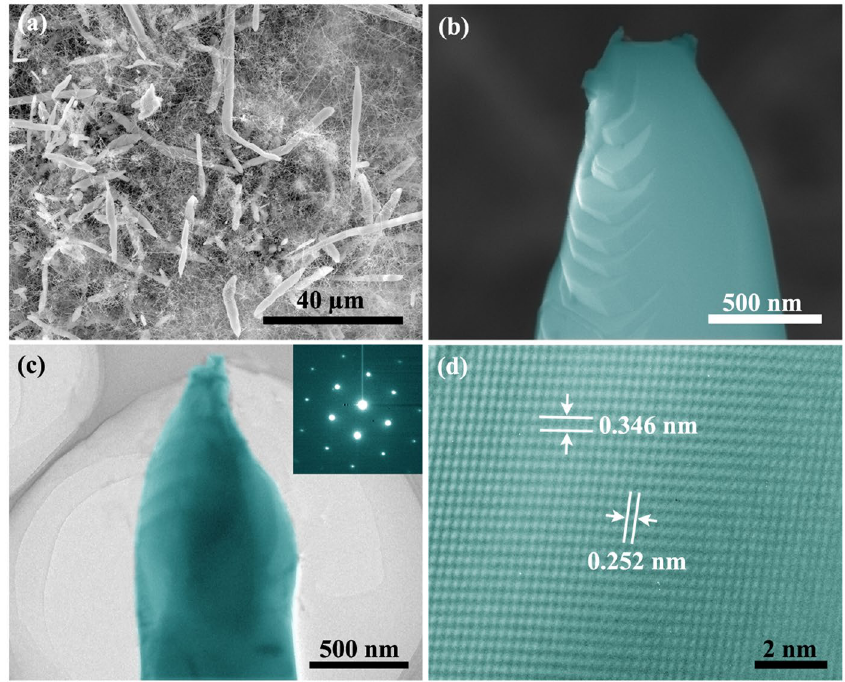
Figure 4. ( a ) SEM surface image of α -Al 2 O 3 nanowires on the as-prepared SiC-Si-Al 2 O 3 ceramics synthesized at 1400 °C with oxygen flow rate of 0.5 sccm; ( b ) SEM image of a representative screw dislocation core on the conical tip of α -Al 2 O 3 nanowires; ( c ) TEM image of the individual Al 2 O 3 nanowire with a conical tip (The inset is the corresponding SAED pattern); ( b ) HRTEM image of the individual α -Al 2 O 3